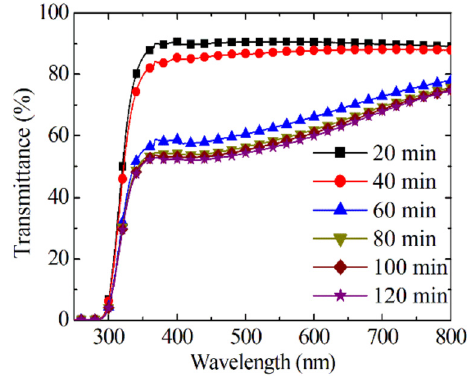
Figure 8. UV-vis spectra of 2 wt% Sn-doped NiO films for different UV/O 3 treatment